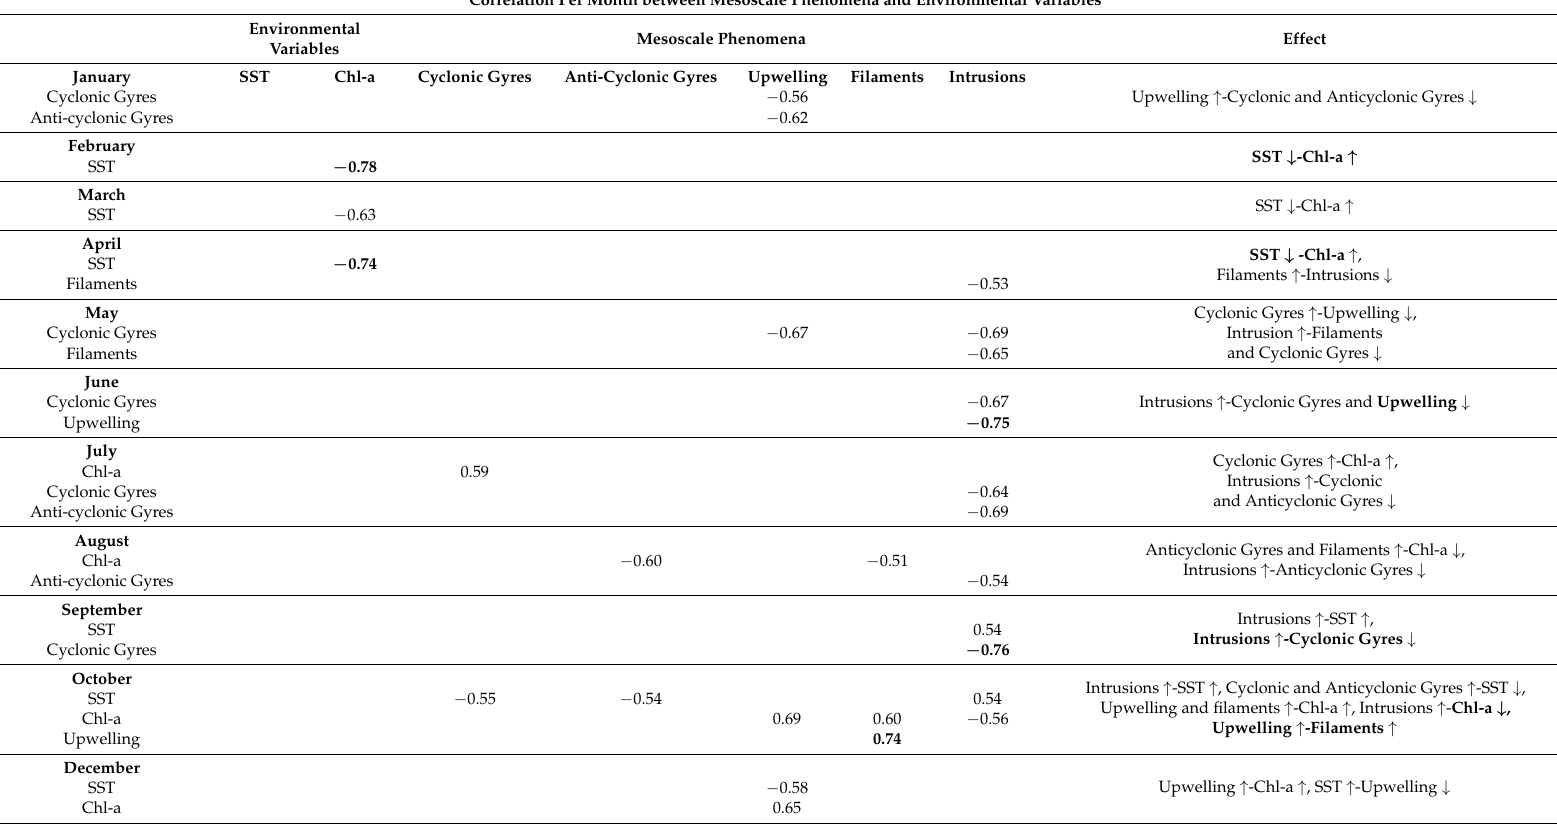
Table 3. Spearman’s (R 2 ) correlation by month between temperature, chlorophyll a and mesoscale phenomena observed in the central and southern coastal regions of Sonora and adjacent deep zone in the Gulf of California, Mexico, from